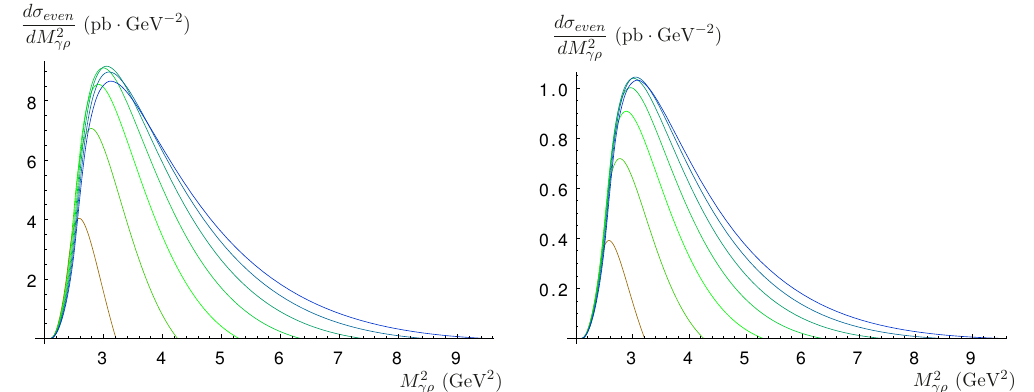
Figure 10 . Differential cross section dσ/dM 2 for a photon and a longitudinally polarized ρ meson γρ production, on a proton (left) or neutron (right) target. The values of S γN vary in the set 8, 10, 12, 14, 16, 18, 20 GeV 2 . (from 8: left, brown to 20: right, blue), covering the JLab energy range. We use here the “valence” scenario.